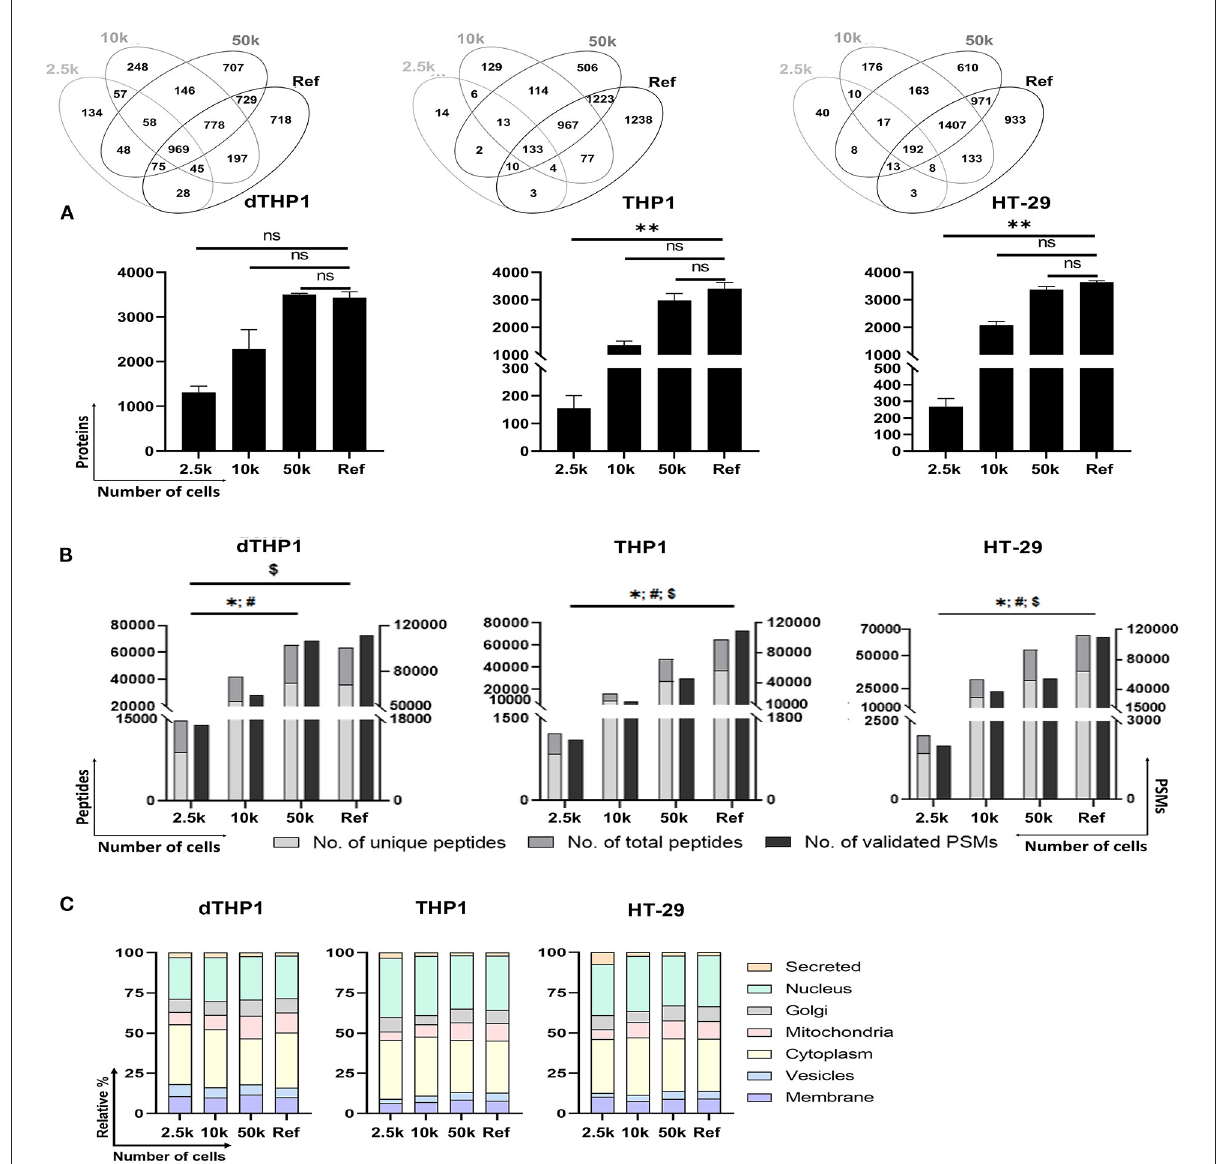
FIGURE3 Performance of P1/urea-SP3 protocol in different low numbers of dTHP1, THP1, and HT-29 cells. (A) Proteins identified per condition and cell type, with at least 2 unique peptides. (B) Peptides (unique and total) and peptide spectrum matches (PSMs) per condition. (C) Subcellular location distribution calculated as relative percentage (%) per total proteins. Protein locations were annotated according to UniProt database. Lists of proteins can be found in Supplementary Table 3 (dTHP1) and Supplementary Table 7 (THP1 and HT-29). In all panels, a reference (Ref) sample containing 20 µ g of protein of each cell line was used as a control for maximum proteome coverage. P -values: * < 0.05; ** ≤ 0.01; ns, not significant. For (B) : *, unique peptides; #, total peptides; $, validated PSMs. Significant differences were calculated using Kruskal-Wallis with Dunns’ test for correcting for multiple